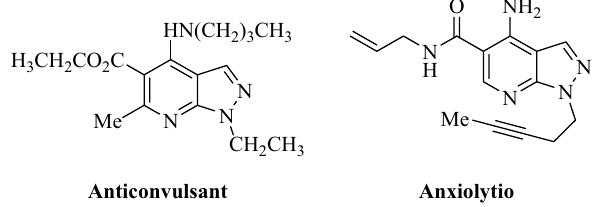
Figure 1. A few examples of fused pyrazoles with biological properties.